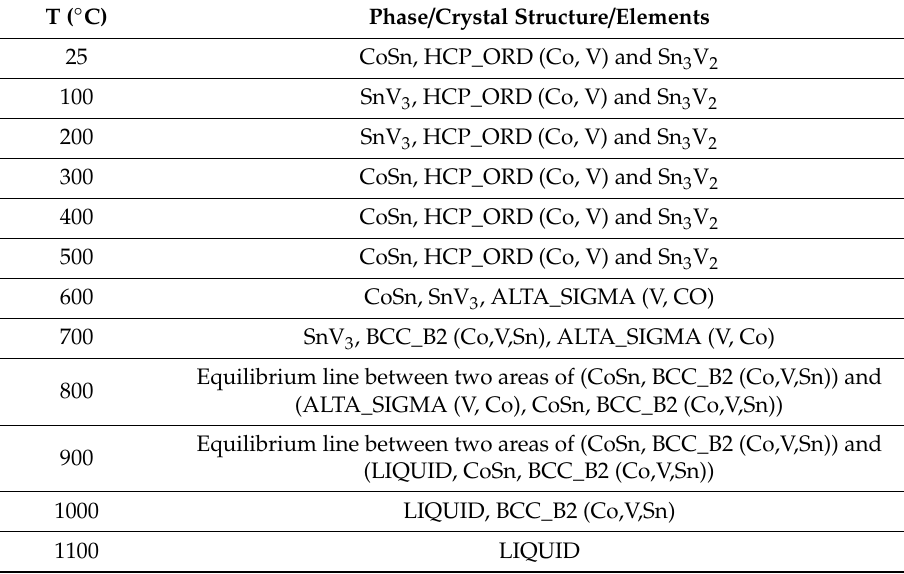
Table 3. The phase composition of CoVSn compound (1:1:1) at the temperature of 25 to 1100 ◦ C. T ( ◦ C) Phase / Crystal Structure / Elements